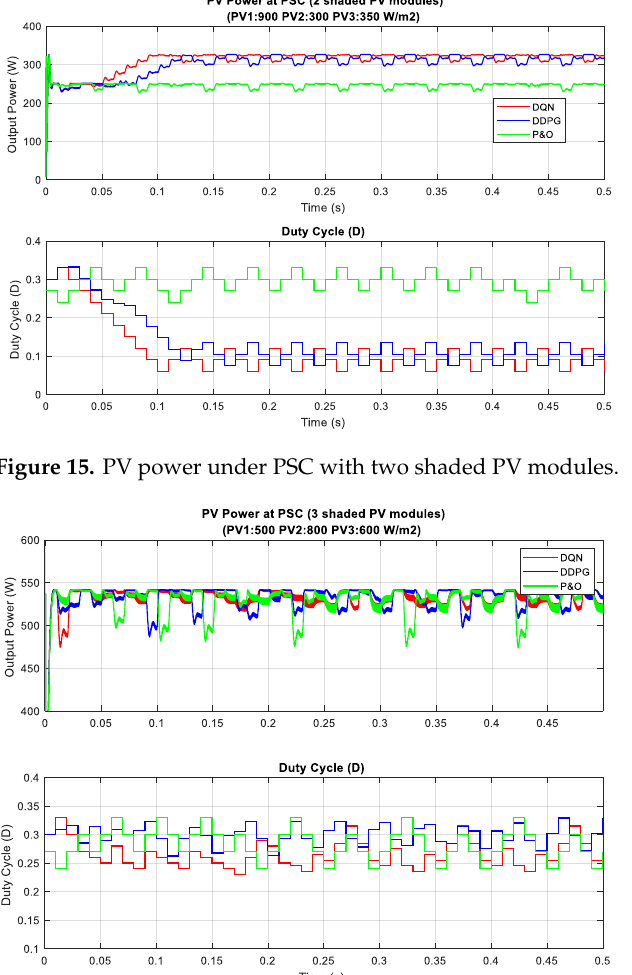
Figure 16. PV power under PSC with three shaded PV modules.